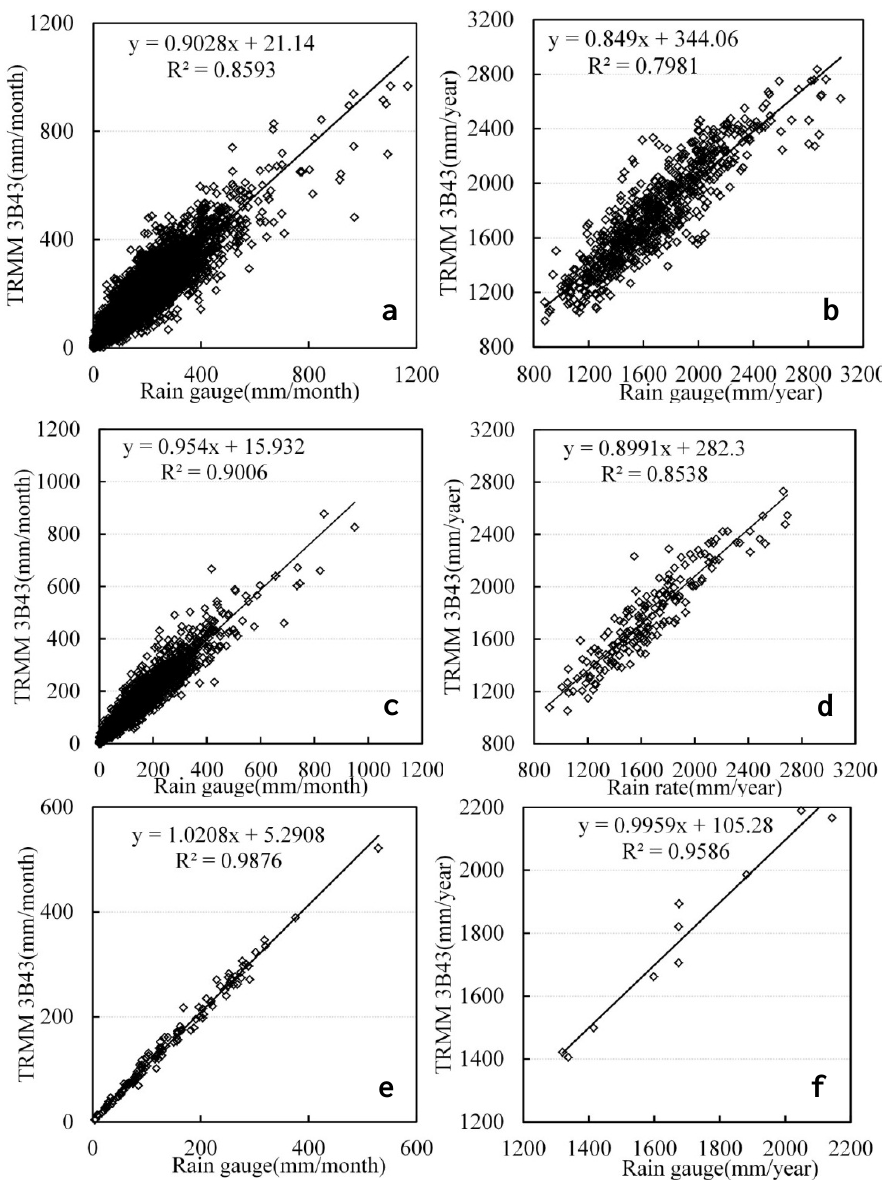
Figure 4. Scatter plots of TRMM 3B43 versus rain ‐ gauge data for the period from 1998 to 2007, with ( a , b ) for 0.25° × 0.25° pixel scale; ( c , d ) for 1° × 1° pixel scale; ( e , f ) for basin scale; ( a , c , e ) for monthly scale; ( b , d , f ) for annual scale. Table 1. Validation statistics comparing satellite rainfall estimates with gauge data at the annual scale.